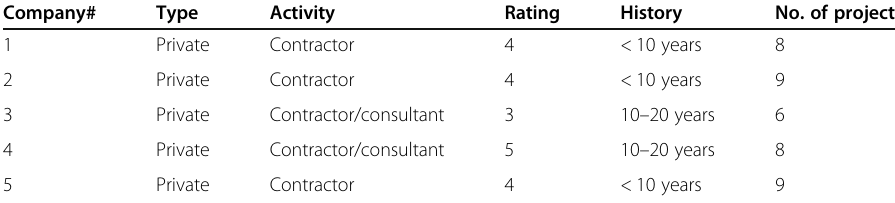
Table 3 Information of 5 companies studied here